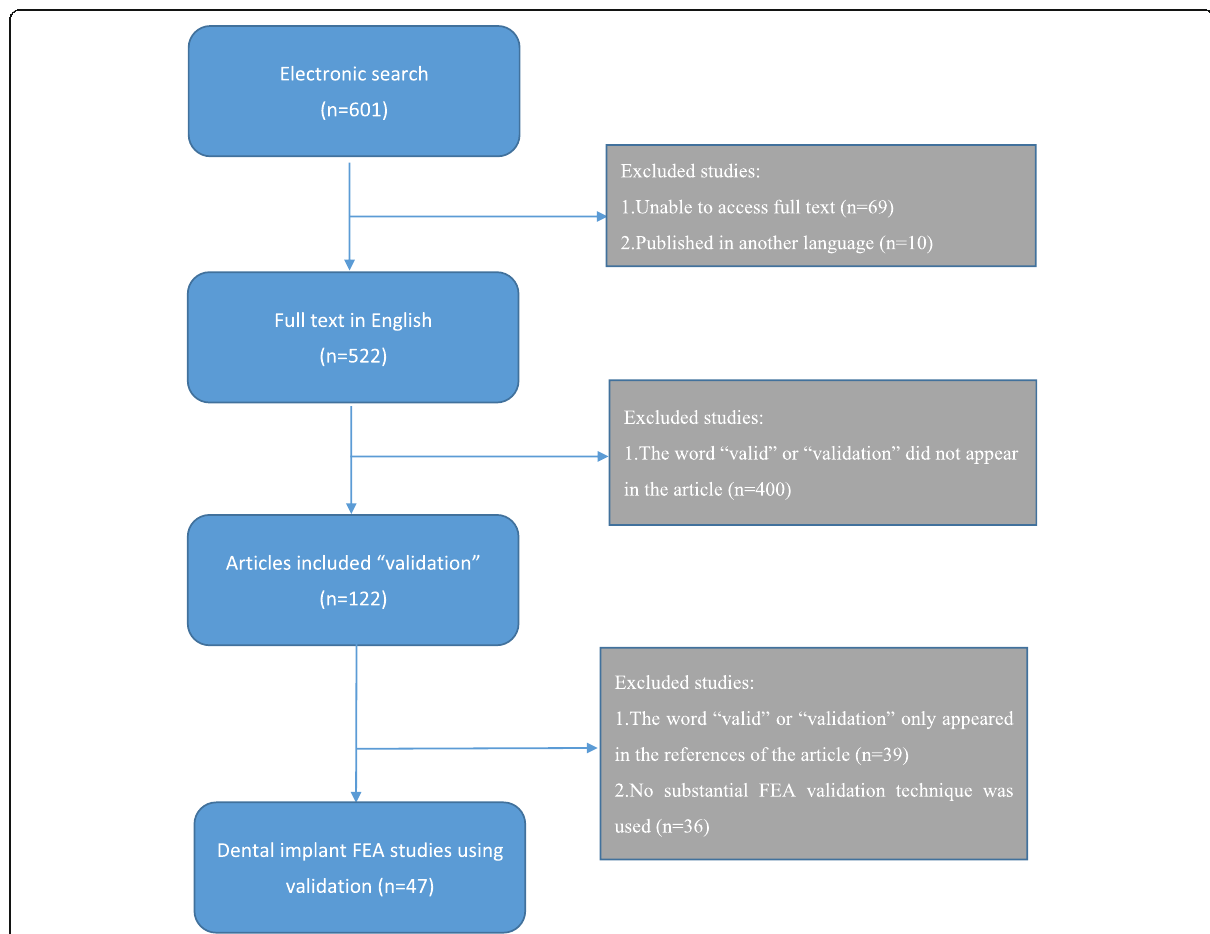
Fig. 1 Flowchart of literature review. An electronic literature search of PubMed was conducted up to January 2017 using the Medical Subject Headings “ dental implants ” and “ finite element analysis. ” After accessing the full texts, the context of each article was searched using the words “ valid ” and “ validation ” and articles in which these words appeared were read to determine whether they met the inclusion criteria for the